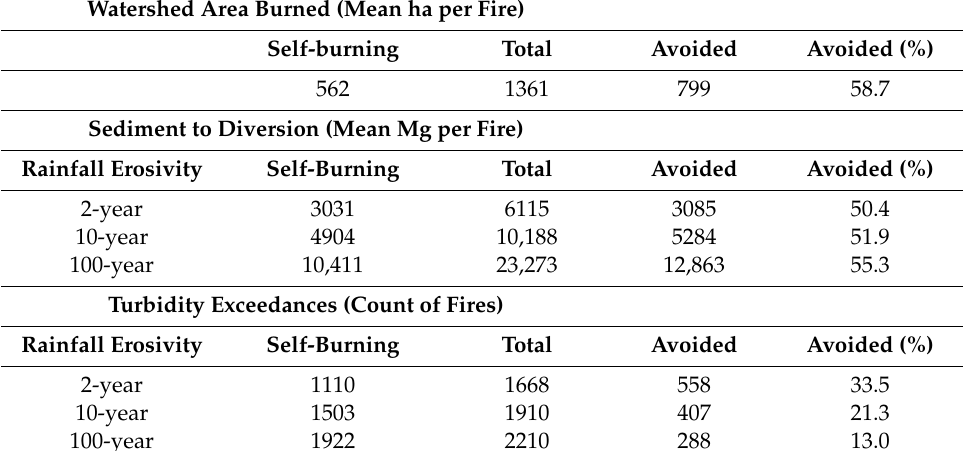
Table 3. Summary of water supply impacts across all fires by containment scenario and rainfall erosivity. A turbidity threshold of 100 NTU was used to compute the number of exceedances.